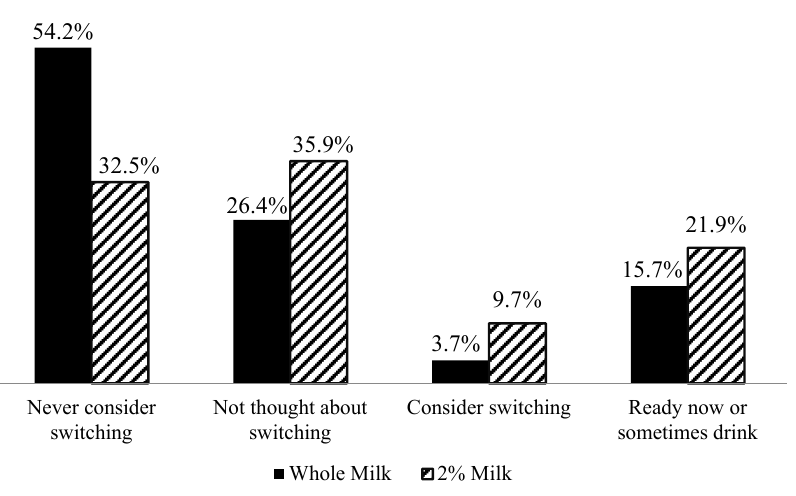
Figure 1. Stages of change constructs (whole and 2% milk users; weighted).